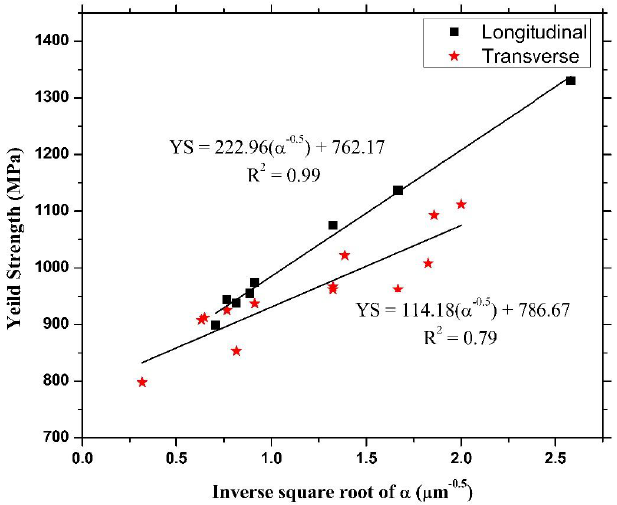
Figure 3. Hall–Petch relationship between α lath size and yield strength for as-built and heat-treated samples.